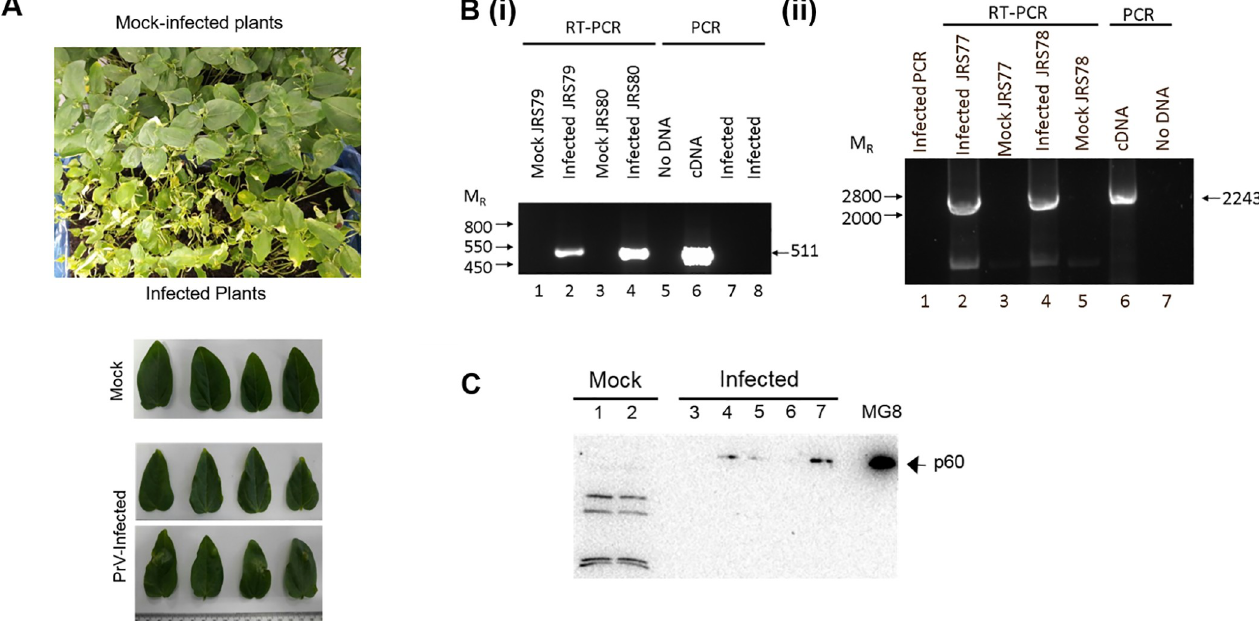
Fig 2. PrV replication in the cowpea plants. (a) Comparison of leaves from mock infected and PrV-infected cowpea plants. (b) RNA was isolated from macerated mock infected or PrV-infected leaves. Reverse transcription reactions were performed with specific primers to detect the (+)-sense (JRS80 or JRS78) or the (-)-sense (JRS79 or JRS77) RNA. The cDNA was probed for the presence of a 5’ region of the PrV genome or the CP sequence with the primers JRS79-JRS80 or JRS77-JRS78 respectively. For the control reactions, 1 μ g pFLM (cDNA) was used. (c) Western analysis of the PrV proteins purified from individual leaves. Leaves from mock infected plants (lanes 1 and 2) and PrV-infected (lanes 3–7) were separated on an SDS-PAGE gel and western analysis performed with anti-PrV CP (rabbit) and anti-rabbit HRP (goat) antibodies. The sizes of the bands detected were compared to an extract from H . zea MG8